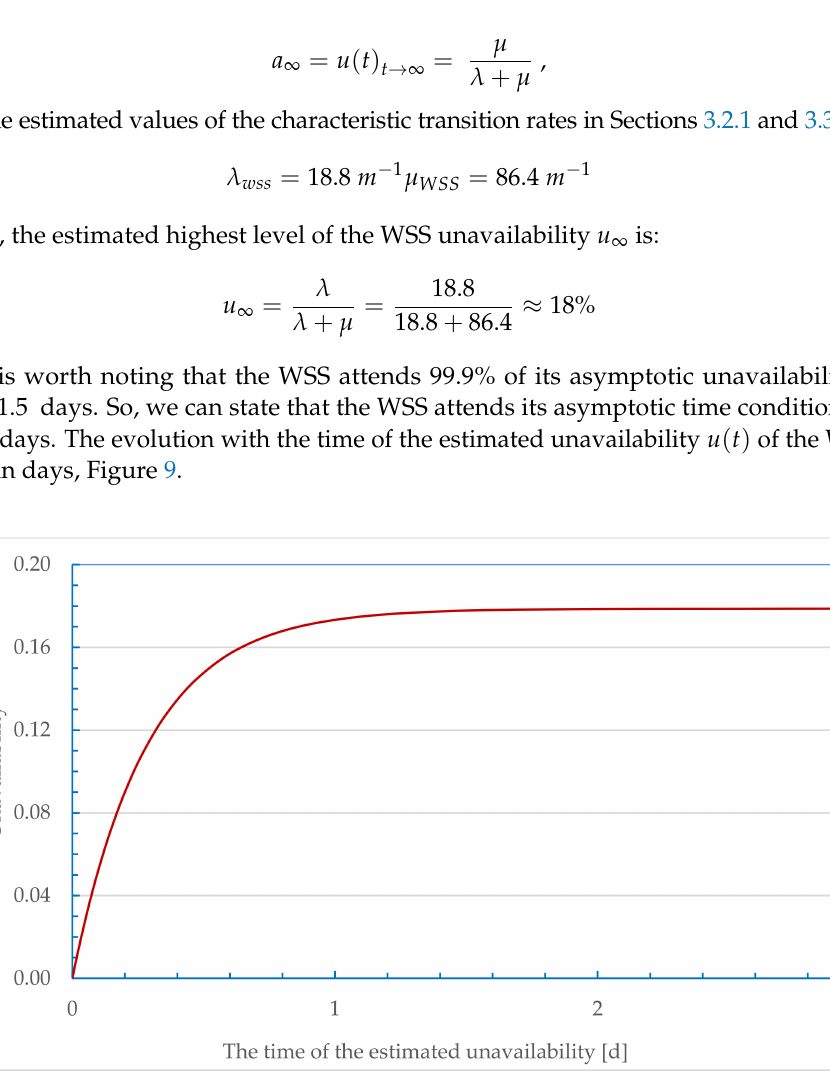
Figure 9. The time evolution of the estimated unavailability u(t) of the